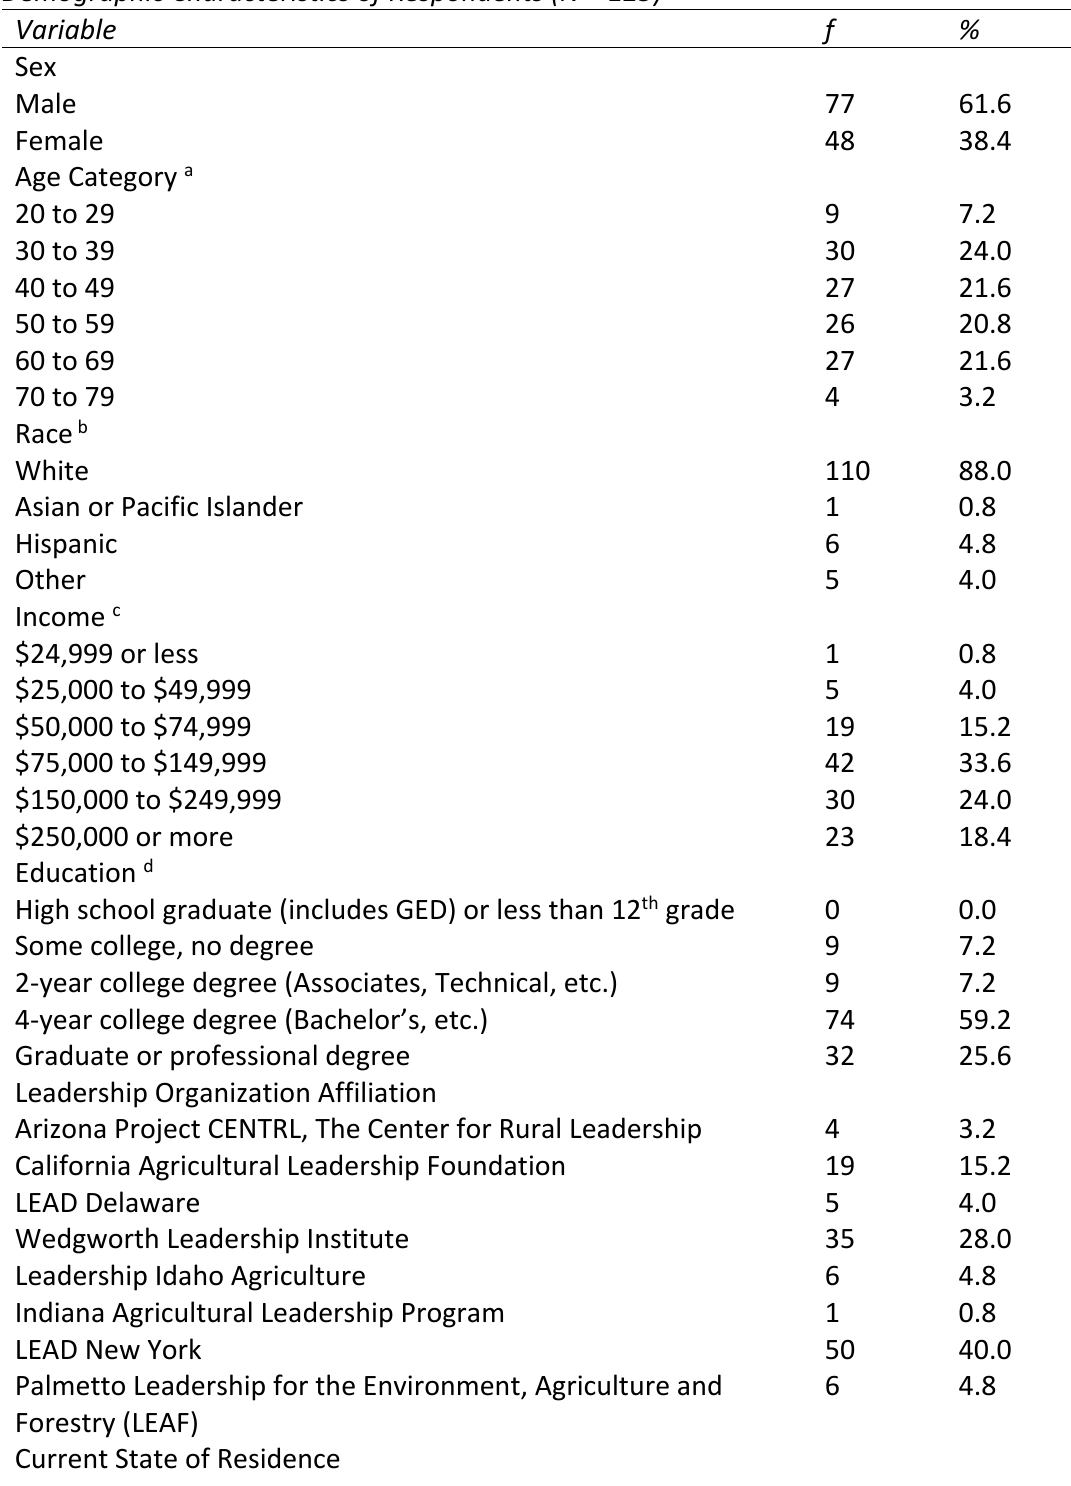
Demographic Characteristics of Respondents (N =